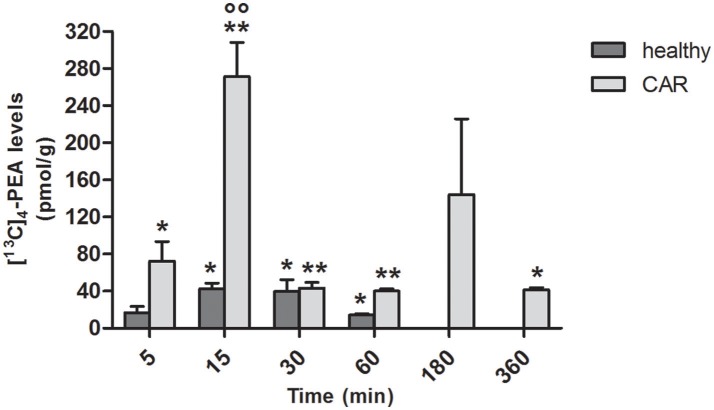
Time-course of [13C]4-PEA levels in paw tissue of healthy and CAR-injected rats following oral administration of [13C]4-PEA-um. Levels of [13C]4-PEA in the paw of healthy and CAR-injected rats were determined after oral administration of 30 mg/kg [13C]4-PEA-um. Data are means ± SEM of five animals for each group. *P < 0.05 vs. baseline; **P < 0.001 vs. baseline; °°P < 0.001 vs. healthy rats.